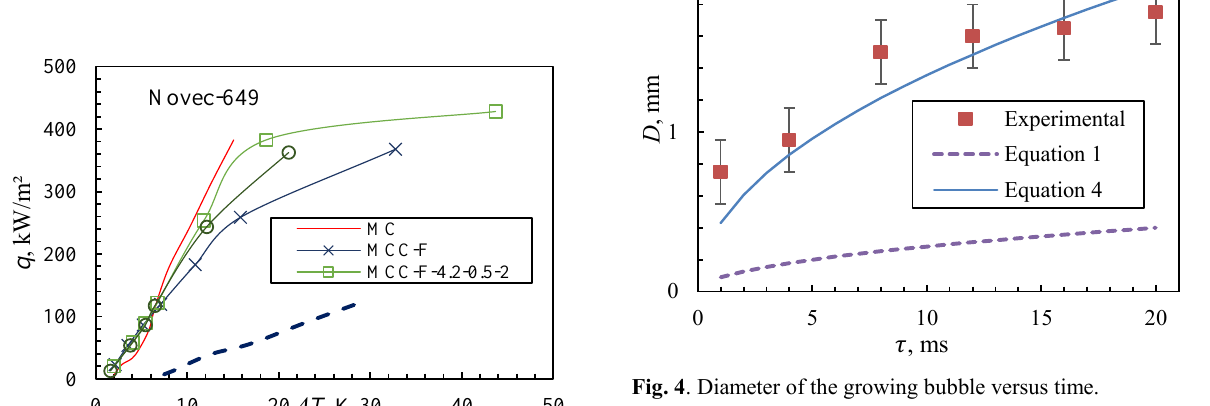
Fig. 2 . Boiling curves for Novec-649, heat transfer coefficient versus heat flux.